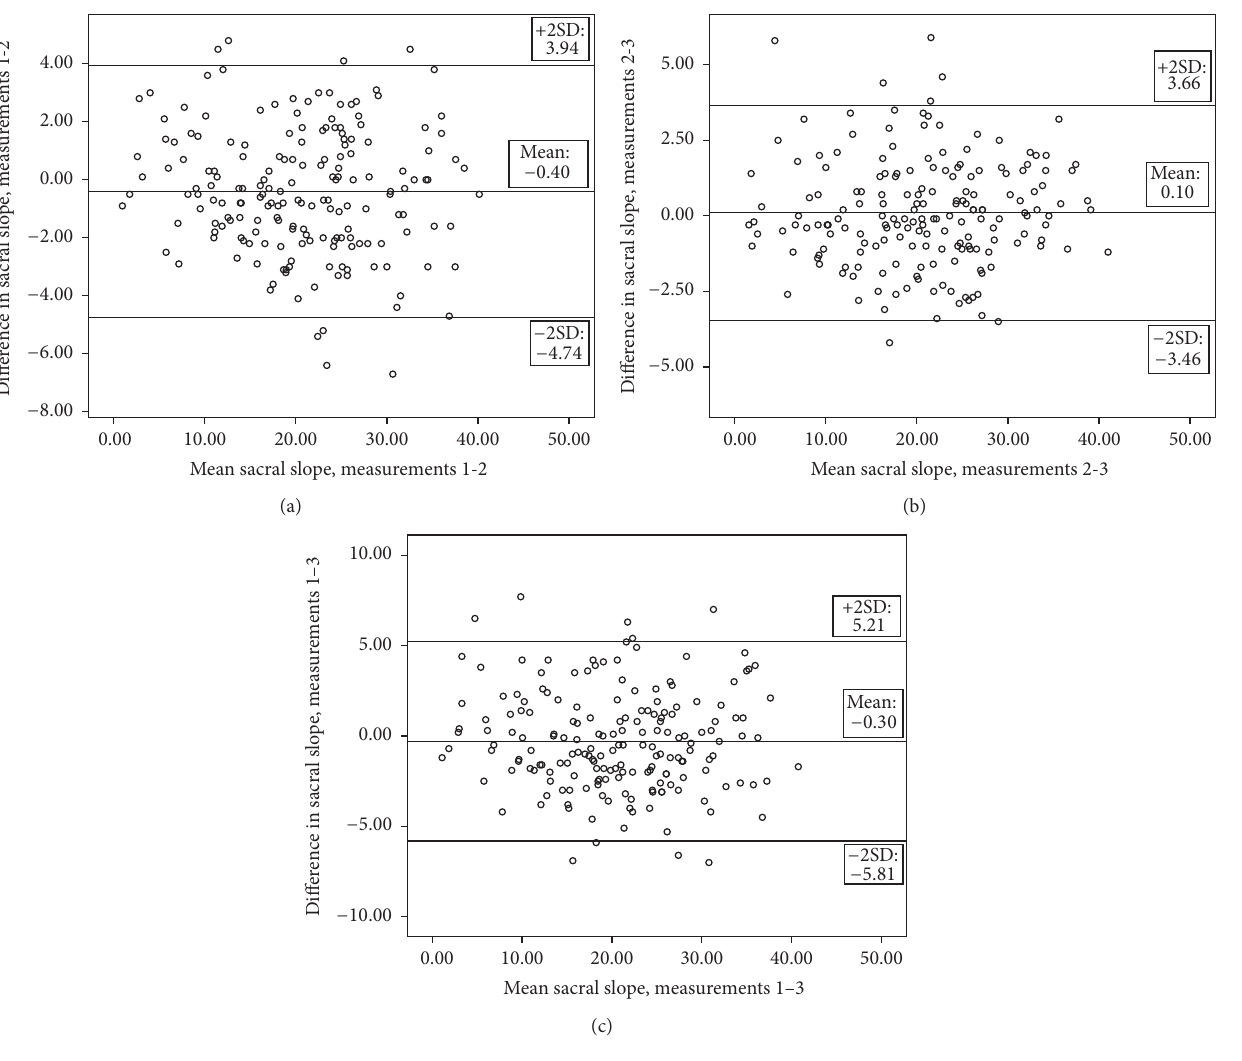
Figure 3: Bland and Altman plots for sacral slope measurements, indicating mean differences and 95% limits of agreement between (a) measurements 1 and 2, (b) measurements 2 and 3, and (c) measurements 1 and